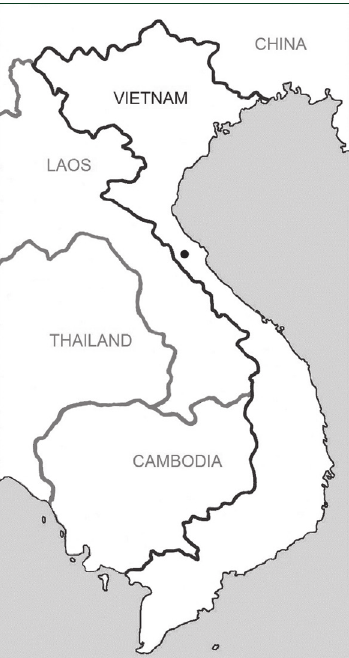
Figure 3. Distribution (dot) of Aristolochia quangbinhensis T.V. Do in Central